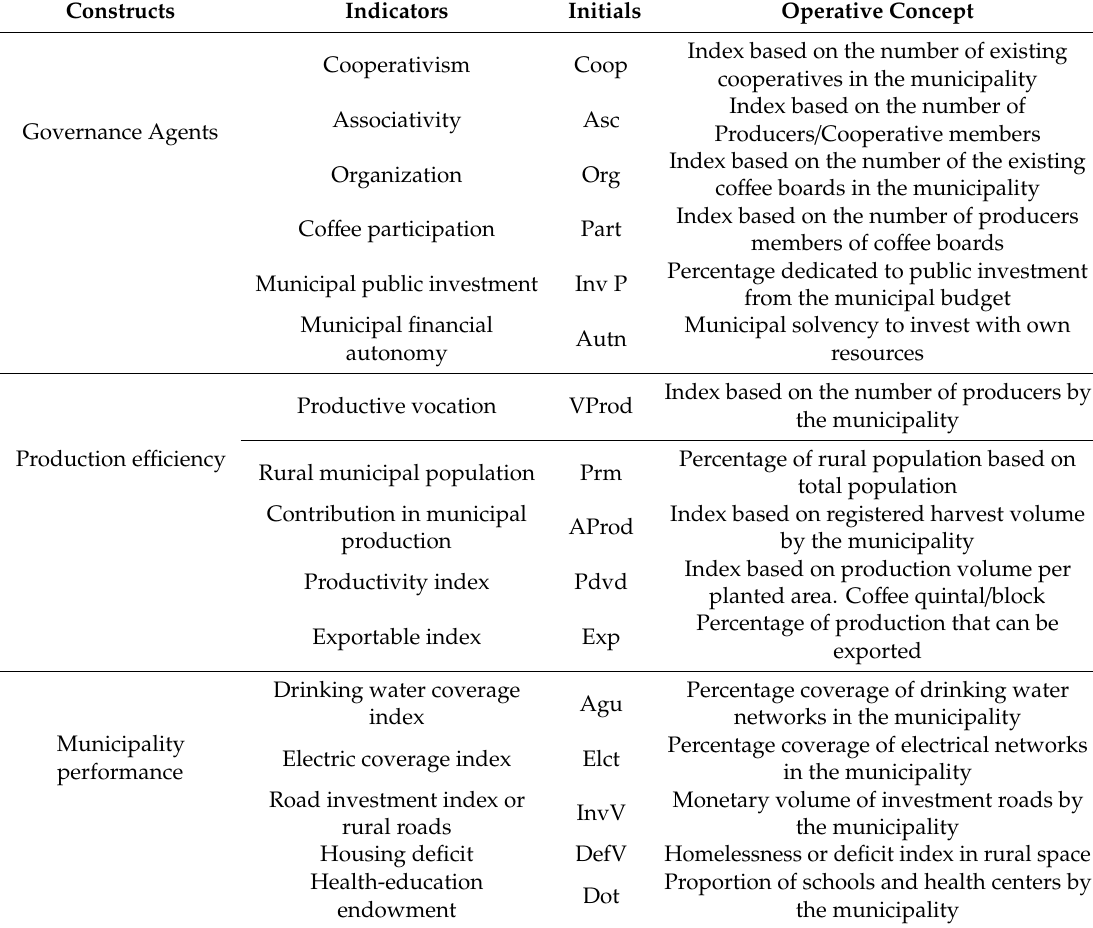
Table 1. Constructs and indicators identified from the theoretical model under